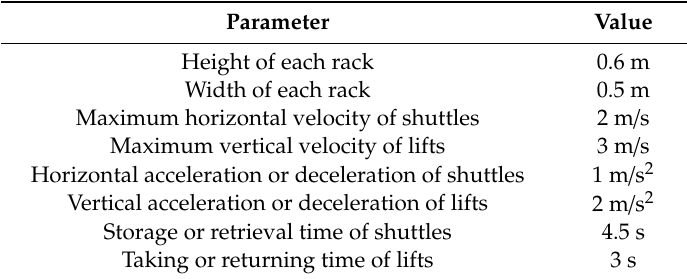
Table 5. Parameter setting.